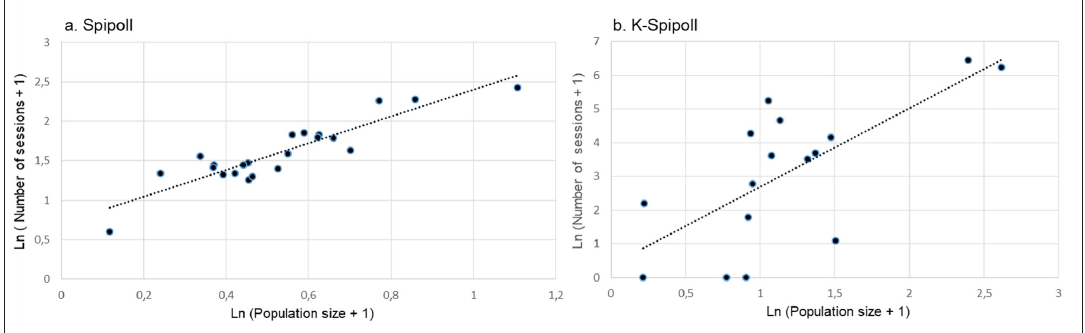
Figure 2: Number of sessions according to the population in administrative regions in France (a) and South Korea (b) .